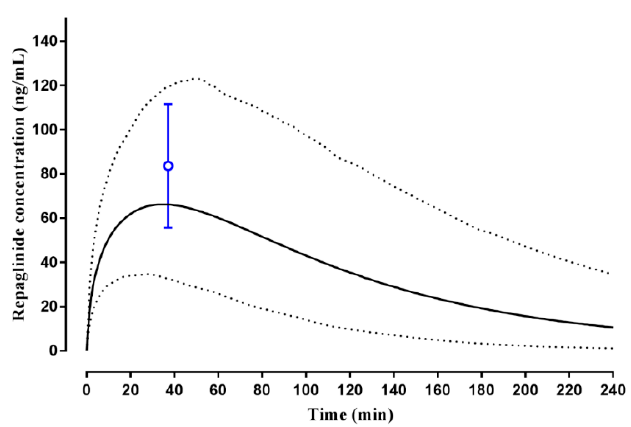
Figure 7. Simulated plasma concentration–time profile of repaglinide in healthy Malay adults. A 4 mg oral dose of repaglinide was administered once daily to adult healthy Malay volunteers ( n = 121) using the custom Malay Simcyp population group. Solid lines represent mean predictions with dotted lines representing the 5th and 95th percentile ranges. Open circles represent data for the observed study [45].